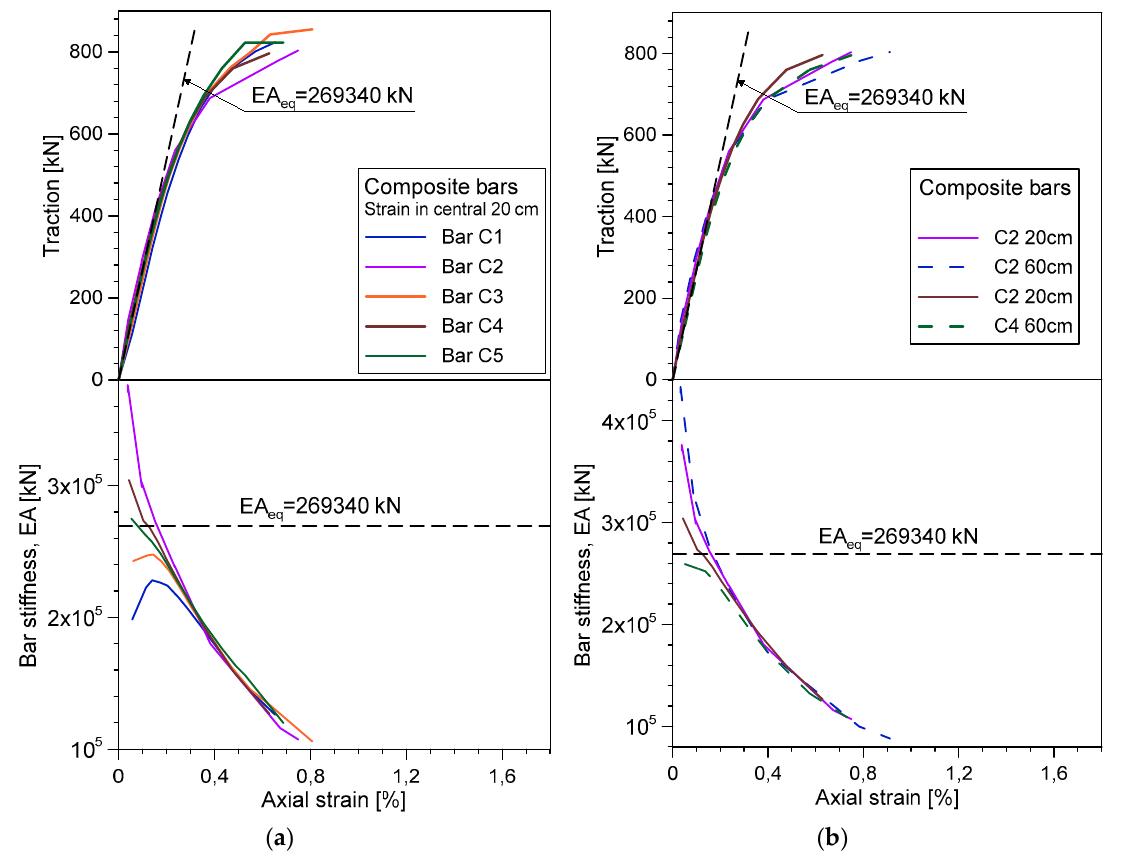
Figure 8. Traction vs strain and bar stiffness vs strain on composite bars tested in the laboratory: ( a ) mean strain recorded by the DFOS in the central 20 cm; ( b ) mean strain recorded by the DFOS in the central 20 cm vs entire portion BC.